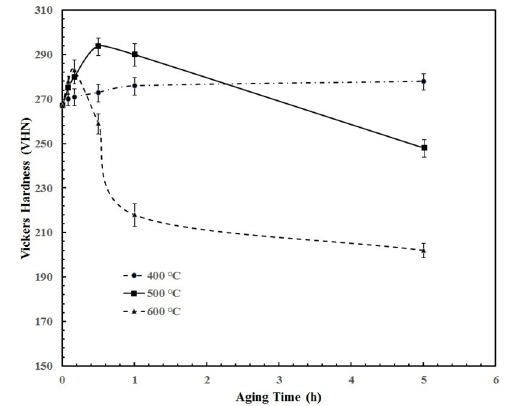
Figure 8. Aging curves of Cu-4wt. % Ti alloy aged at 400, 500 and 600